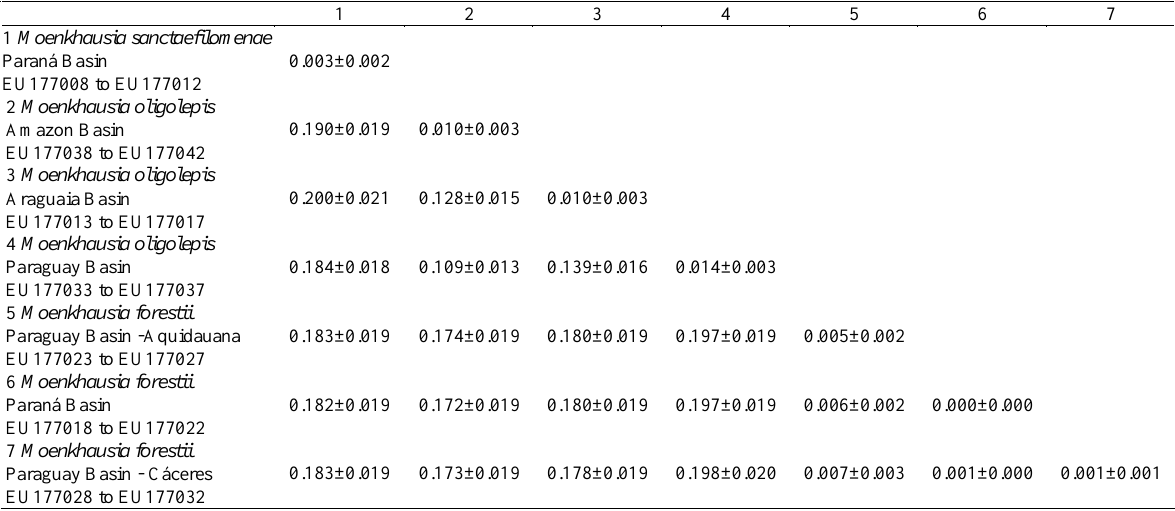
Table 2. Genetic distance (mean ± standard error) among fishes of each locality (diagonal) and among samples from different localities (below diagonal). Numbers after species names are Genbank accession